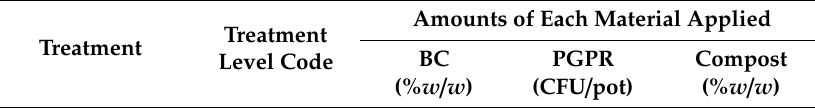
Table 2. Biochar (BC), compost and plant growth-promoting rhizobacteria (PGPR) treatments applied in the experiment. Separate applications: only one material added to the soil in di ff erent doses; combined application: at least two materials added to the soil in di ff erent doses. (“n”: number of replications for each treatment